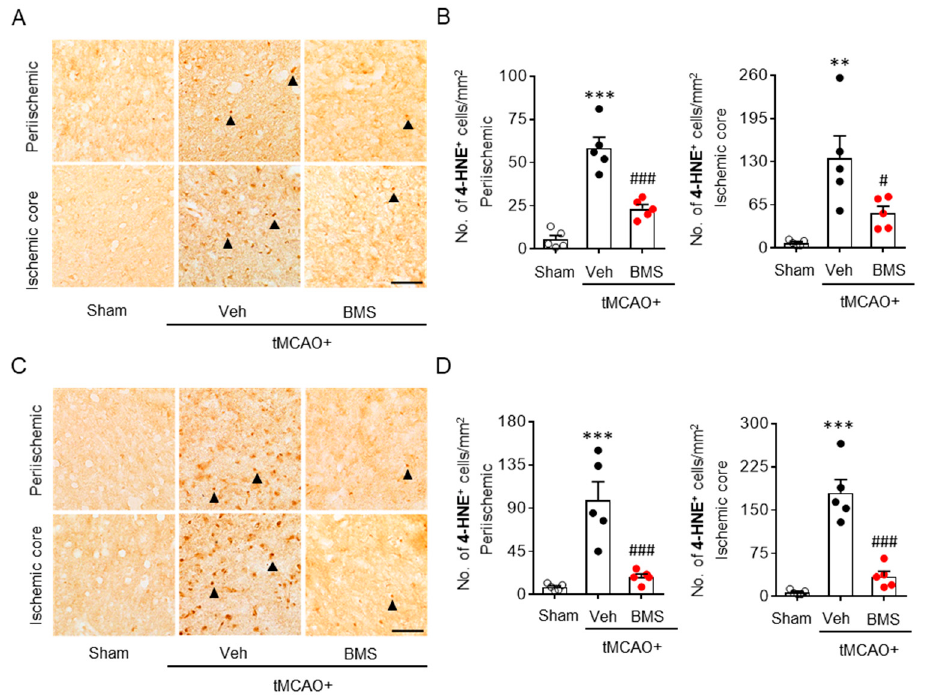
Figure 3. BMS administration attenuates lipid peroxidation in mice at one day and three days after tMCAO challenge. Mice were challenged with tMCAO. BMS (5 mg / kg) was administered to mice immediately after reperfusion. E ff ects of BMS on tMCAO-induced lipid peroxidation were assessed at one day ( A , B ) and three days ( C , D ) after tMCAO challenge. Representative images of 4-HNE-positive cells ( A , C ) in periischemic and ischemic core regions. Scale bars, 50 µ m. Arrowheads indicate 4-HNE-positive cells. Quantification of 4-HNE-positive cells in periischemic and ischemic core regions ( B , D ). n = 5 mice per group. ** p < 0.01 and *** p < 0.001 versus sham. # p < 0.05 and ### p < 0.001 versus vehicle-administered tMCAO mice (Veh + tMCAO).